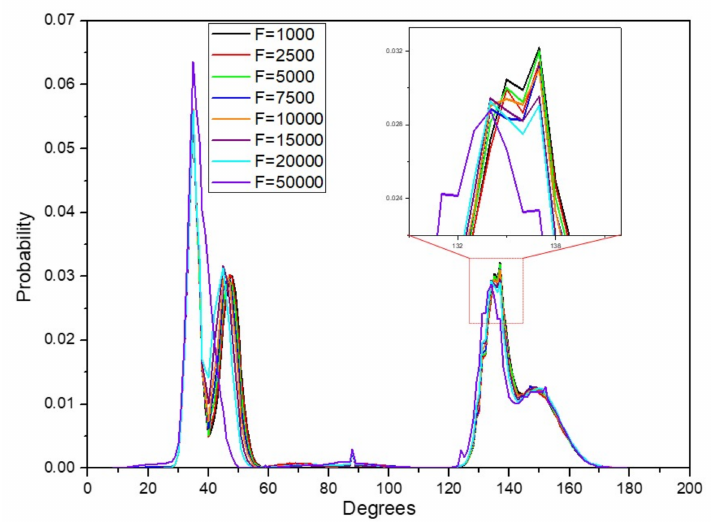
Figure 9. Distribution of dihedral ω